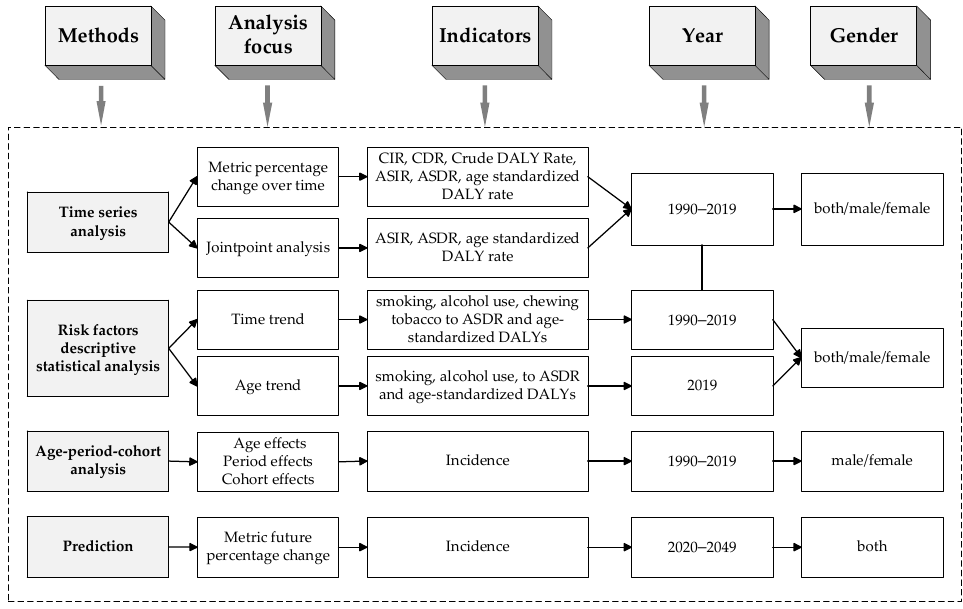
Figure 1. Analysis roadmap of this study.